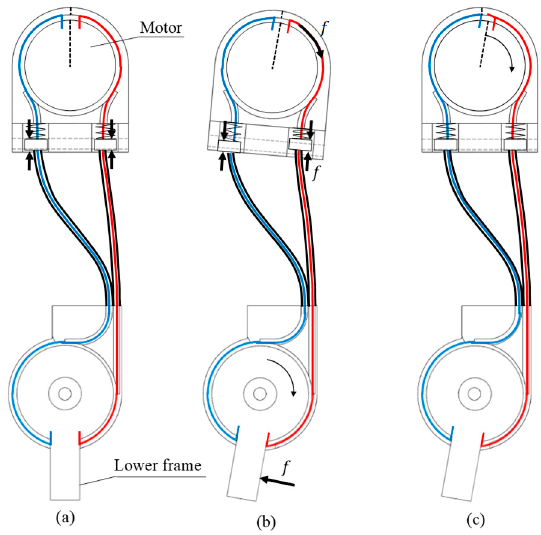
Figure 7. Principal of friction compensation. ( a ) There is no load between the wearer and the exoskeleton. ( b ) The motor does not rotate, but the lower frame can rotate because of the spring. ( c ) The load between the wearer and the exoskeleton is decreased by the control.